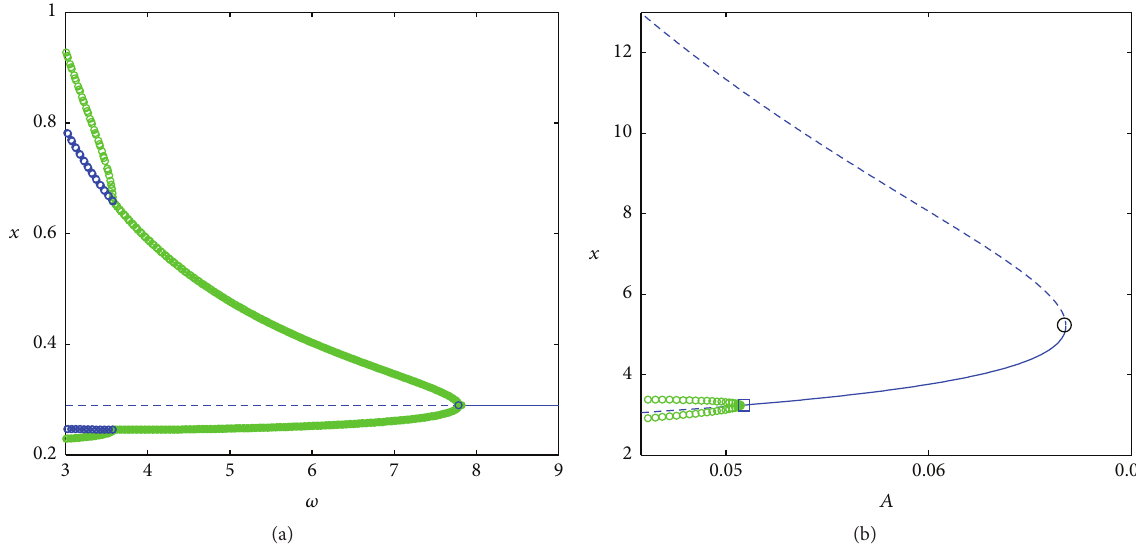
Figure 1: Hopf bifurcation induced, respectively, by 𝜔 and 𝐴 . (a) Hopf and period-doubling bifurcations are exhibited with 3 < 𝜔 < 9 , 𝐴 = 0.2 , 𝑏 = 0.5 , 𝑐 = 0.1 , 𝑑 = 0.2 , ℎ = 1.0 , 𝛽 = 2 , 𝛼 = 0.6 , and 𝑚 = 0.2 . (b) Hopf and saddle-node bifurcations when 0.045 < 𝐴 < 0.07 , 𝜔 = 1.0 , 𝑏 = 0.4 , 𝑐 = 1 , 𝑑 = 0.6 , ℎ = 2.0 , 𝛽 = 2.6 , 𝛼 = 1.8 , and 𝑚 = 0.3 where the black square denotes saddle-node bifurcation. The blue solid and the dash lines denote stable and unstable states, respectively. The green and blue circle lines are used to mark the periodic solution bifurcating from 𝐸 2 .